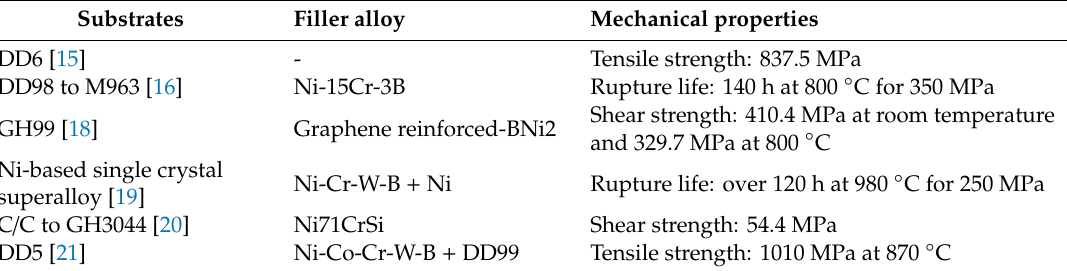
Table 1. Previous studies about the joining of the